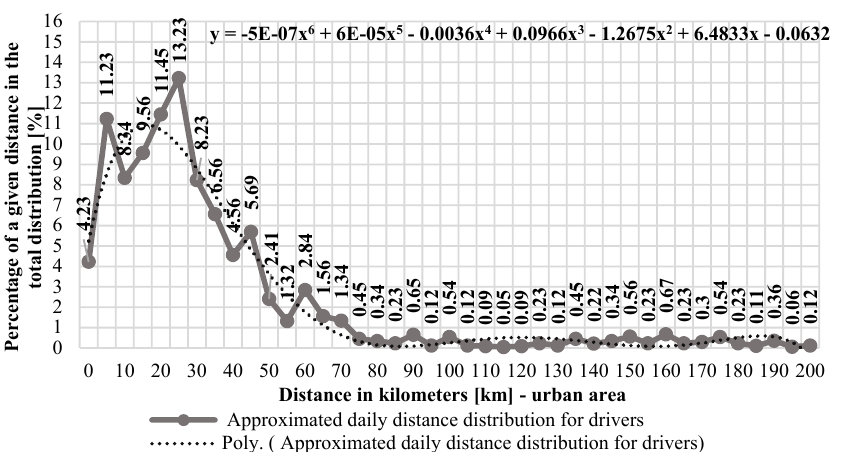
Figure 1. Daily distance distribution for ICEVs, PHEVs, and BEVs operating in urban mode— approximate value based on experimental studies.